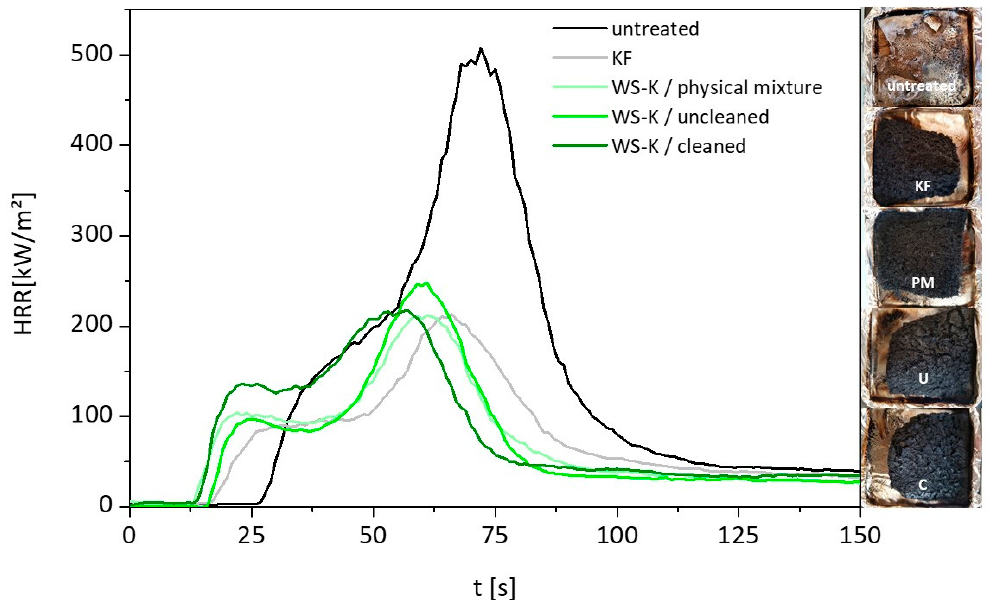
Figure 7. Left, heat release rate curves from CC measurement of untreated wood fibers without additive